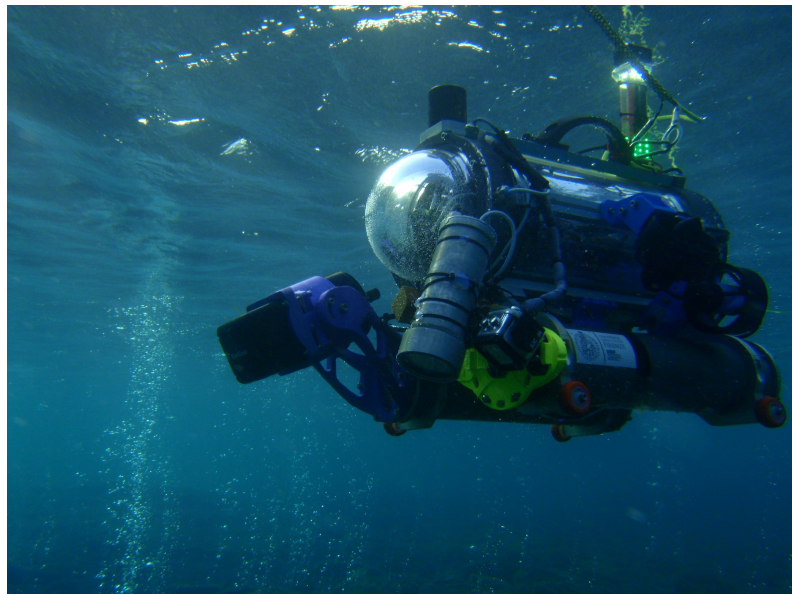
Figure 4. FeelHippo AUV during sea